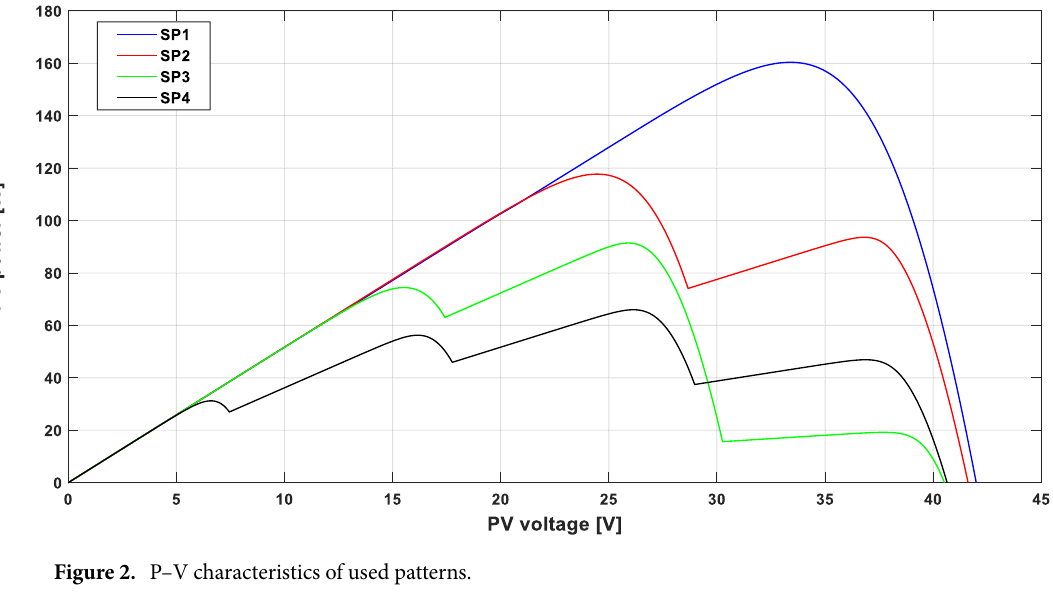
Figure 2. P–V characteristics of used